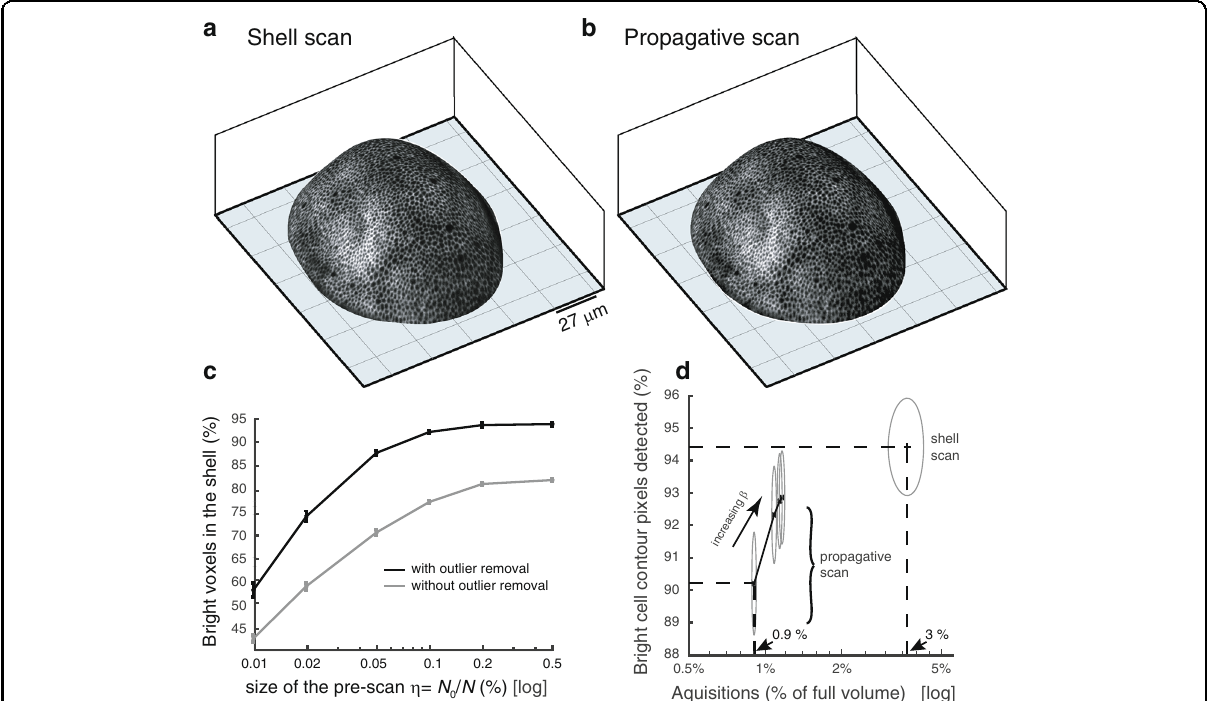
Fig. 4 Accuracy of shell estimation and ability of bright contour acquisition. a , b 3D visualizations of emulated shell-scan and propagative-scan ( β = 5) using raw data from a full scan acquisition. c Goodness of the shell estimated as a function of the size of the pre-scan. The goodness is measured from the percentage of epithelial bright voxels (i.e. bright voxels that are in the ground truth shell) that fall in the estimated shell (the objective being to maximize this quantity). The result is shown with and without outlier removal in the surface estimation step. d Goodness of cell contour delineation with the shell-scan and propagative-scan, as a function of the number of acquisitions required. For the propagative-scan, results with different NN maximal prediction distances β are shown ( β = 1; 3; 5; 10). All points plotted on these curves correspond to the average of the result over 50 different random pre-scans (with error bars in ( c ) and the height and width of ellipses in ( d ) set to their